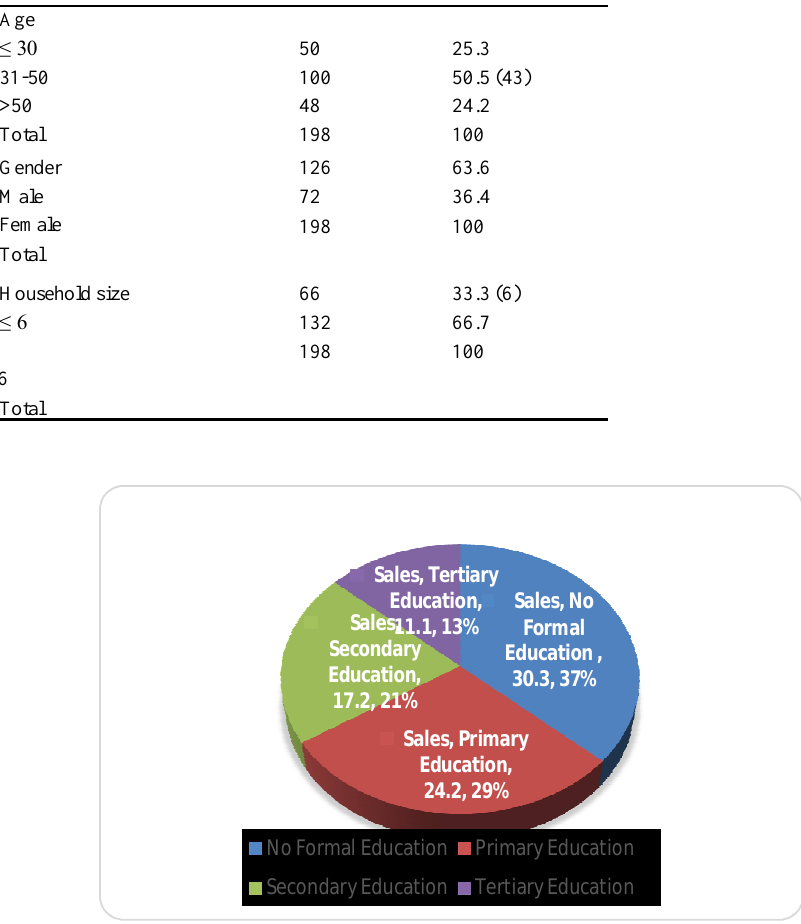
Figure 9: Educational attainment of the